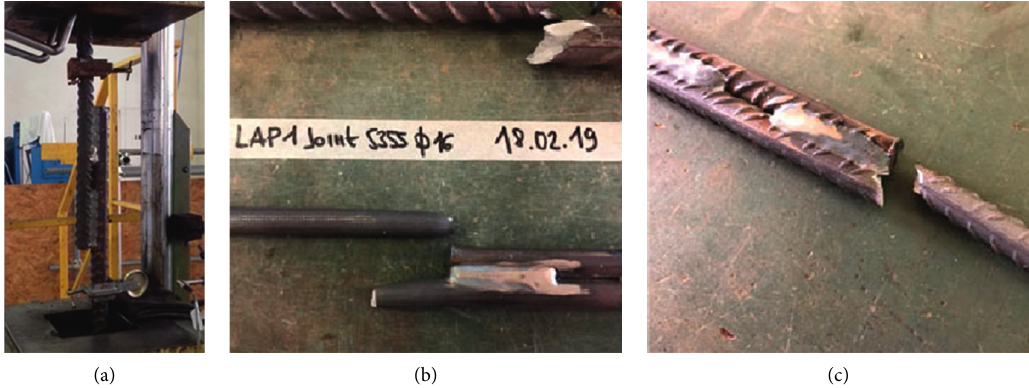
Figure 4: Experimental tests on lap joints (a); example of failure in smooth (b) and ribbed (c) samples of small diameter. In case of ribbed bars (c), the brittle failure close to the HAZ is evident.